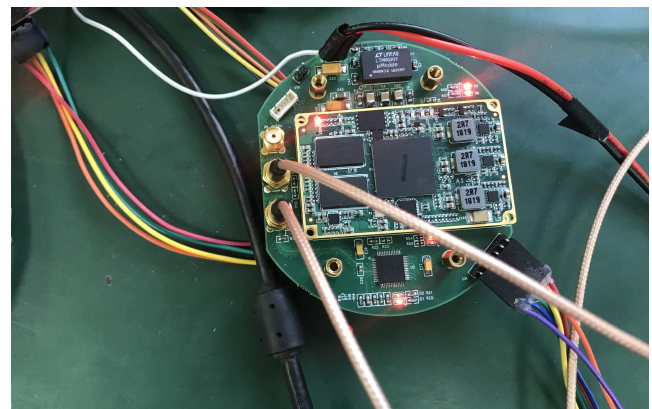
Figure 6. Zynq-7000 platform as the